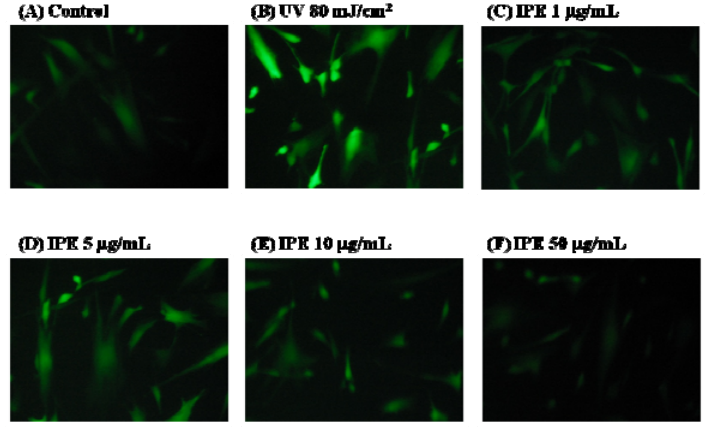
Figure 8. Repressive effect of IPE on intracellular oxidative stress in UV-irradiated Hs68